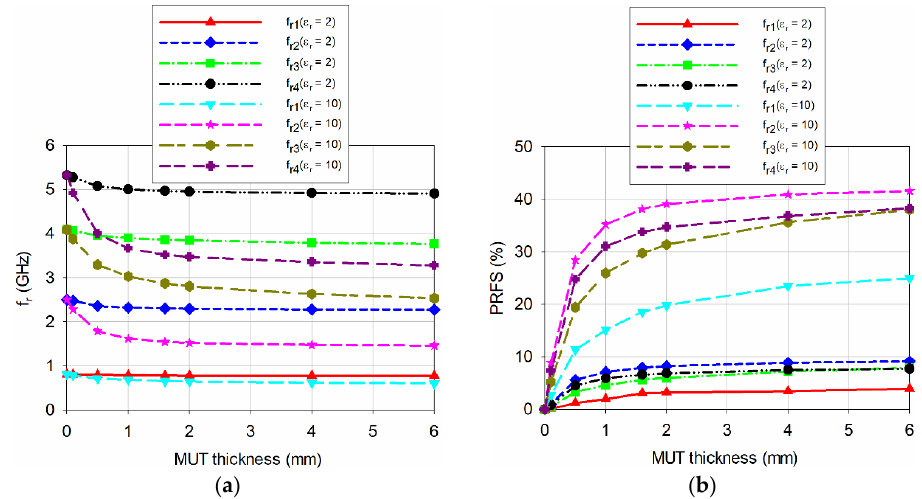
Figure 8. Variations on the first four resonant frequencies for the proposed scaled DR-CSRR DGS-loaded